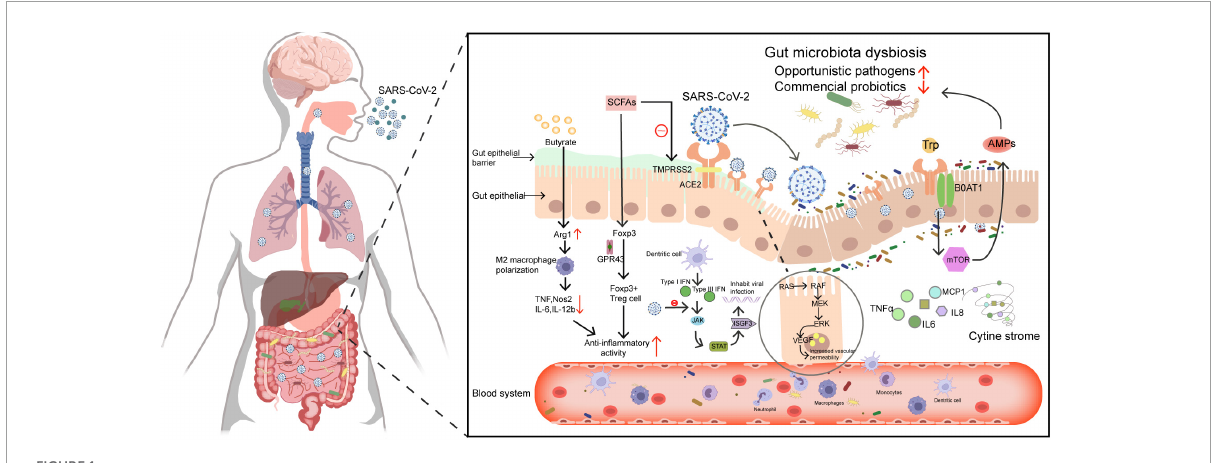
FIGURE1 Schematic diagram of the relationships among SARS-CoV-2, ACE2, host immunity, and microorganisms. (1) Microbiota metabolites such as butyrate exert anti-inflammatory effects by up-regulating arginase 1 (Arg1) expression, down-regulating Nos2, IL6, and IL-12, and inhibiting tumor necrosis factor (TNF) activity. In addition, short-chain fatty acids inhibit histone deacetylases and increase the expression of foxp3 through the GPR43 receptor, thereby enhancing the regulatory function of FOXP3 + Treg cells resulting in anti-inflammatory effects. On the other aspect, short-chain fatty acids can inhibit TMPRSS2 gene expression and up-regulate antiviral pathways to inhibit viral entry. (2) The SARS-CoV-2 is activated by TMPRSS2, binds to ACE2 and enters the gut, can destroy the gut barrier and causes microbiota dysbiosis. (3) SARS-CoV-2 infection suppresses the JAK-STAT pathway of type I and type III interferon responses, and the protein encoded by ISGF3 that limits viral infection will be diminished. Besides, SARS-CoV-2 infection downregulates the expression of ACE2, weakens its ability to regulate the RAS system, and over activates the immune response. Dysregulated gut microbes and their metabolites can also stimulate the production of cytokines, causing a cytokine storm. (4) SARS-CoV-2 spike protein activates the Ras-Raf-MEK-ERK-VEGF pathway in intestinal epithelial cells and promotes vascular endothelial growth factor (VEGF) production, which leads to vascular permeability and inflammation. (5) ACE2 regulates the expression of the amino acid transporter B0AT1, which affects microbiota composition through mTOR-mediated antimicrobial peptide